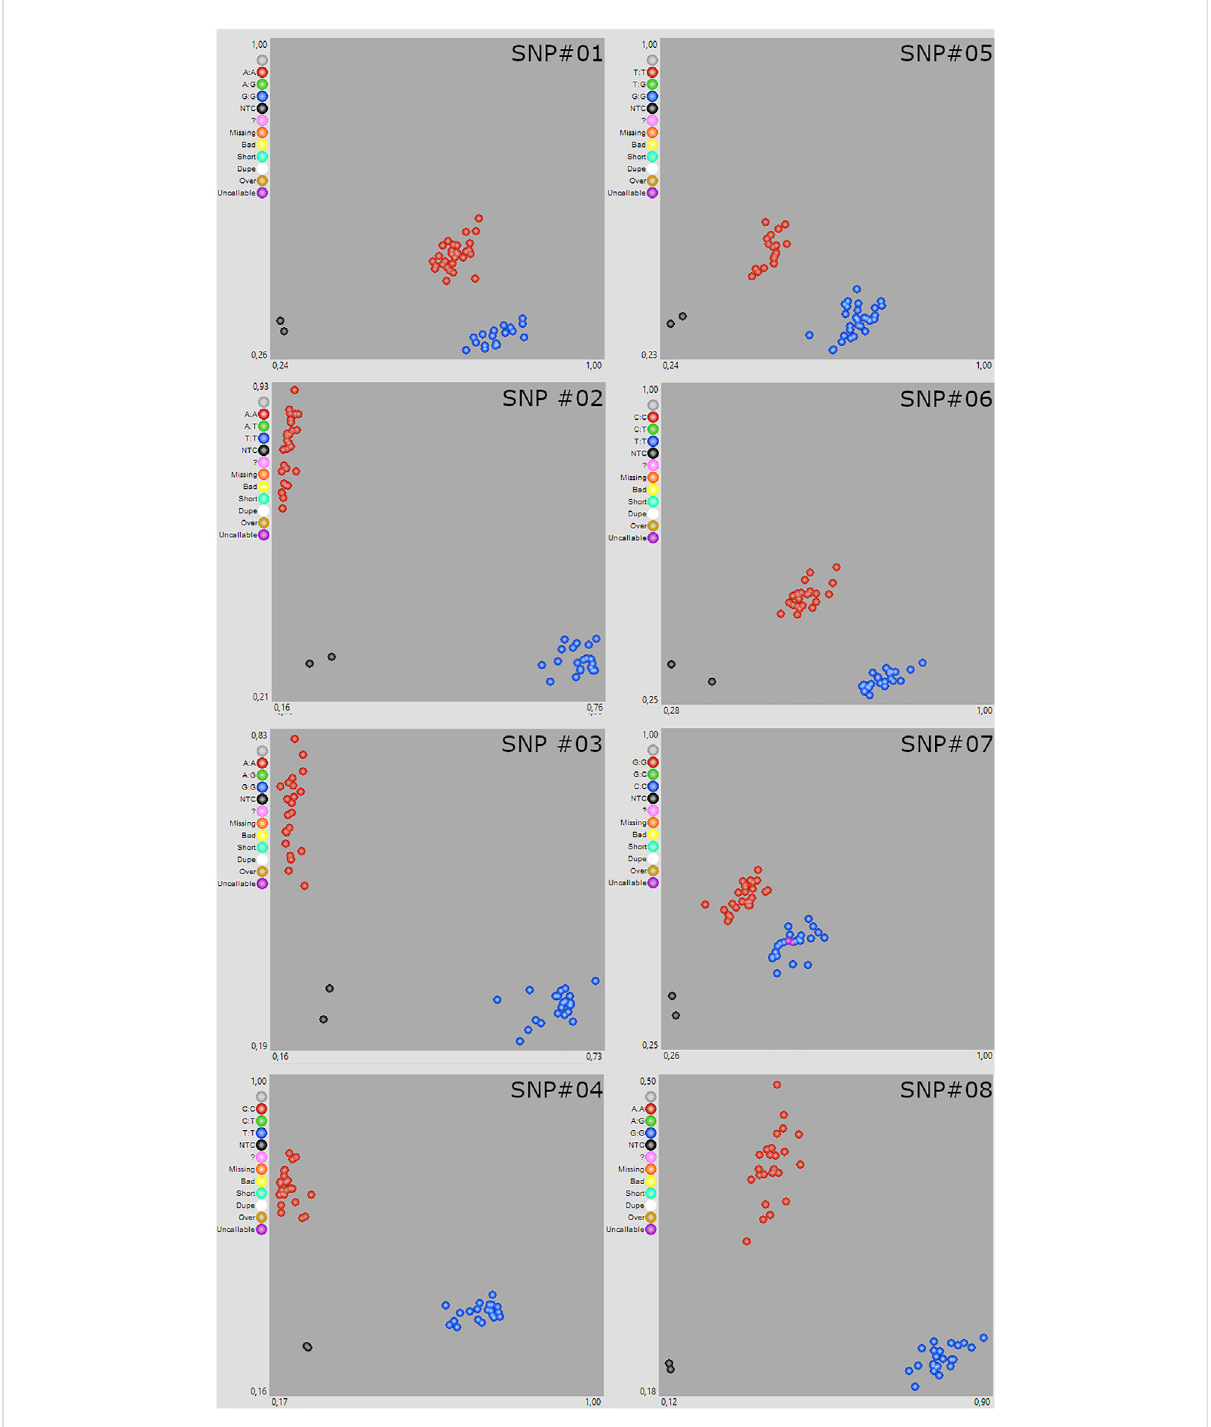
FIGURE 2 Scatter plot for eight Kompetitive Allele-Specifc PCR (KASP) marker assays in 48 wheat varieties. KASP assays showing clustering of individuals on the X-(FAM) and Y-(HEX) axes. Red individuals have the HEX-type allele; blue individuals have the FAM-type allele. In both cases, individuals are homozygous for the reference or alternate allele. Green individuals are heterozygous for the allele. Black dots represent negative control and pink dots uncallable